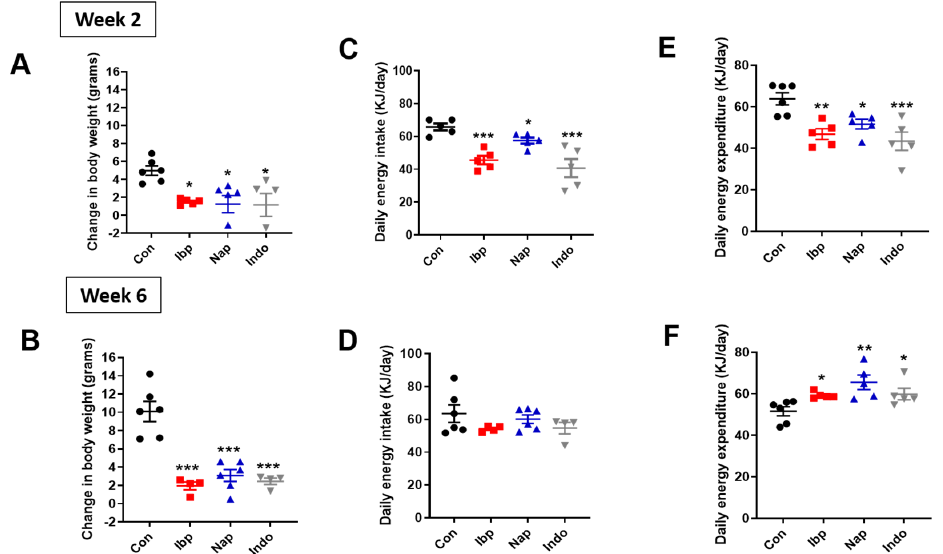
Figure 3. Prolonged intragastric administration of variable NSAIDs protects mice from HFD-induced weight gain. ( A , B ) Change in body weight (grams), ( C , D ) Average daily energy intake (KJ/day) and ( E , F ) total daily energy expenditure (KJ/day) during week 2 and week 6 post-intragastric gavage of PBS/control (Con), ibuprofen (Ibp), naproxen, (Nap), or indomethacin (Indo) in C57 Blc/6J male mice placed on a high-fat diet (HFD). All results are presented as mean ± SEM (error bars). One-way ANOVA was used to compared means of each NSAID group to the control group. n = 6 (Con), 4 (Ibp), 5–6 (Nap), and 4–7 (Indo). ANCOVA correction for body weight was applied for total daily energy expenditure. Statistical significances are denoted with asterisks as follows: *, p ≤ 0.05; **, p ≤ 0.01; ***, p ≤ 0.001.